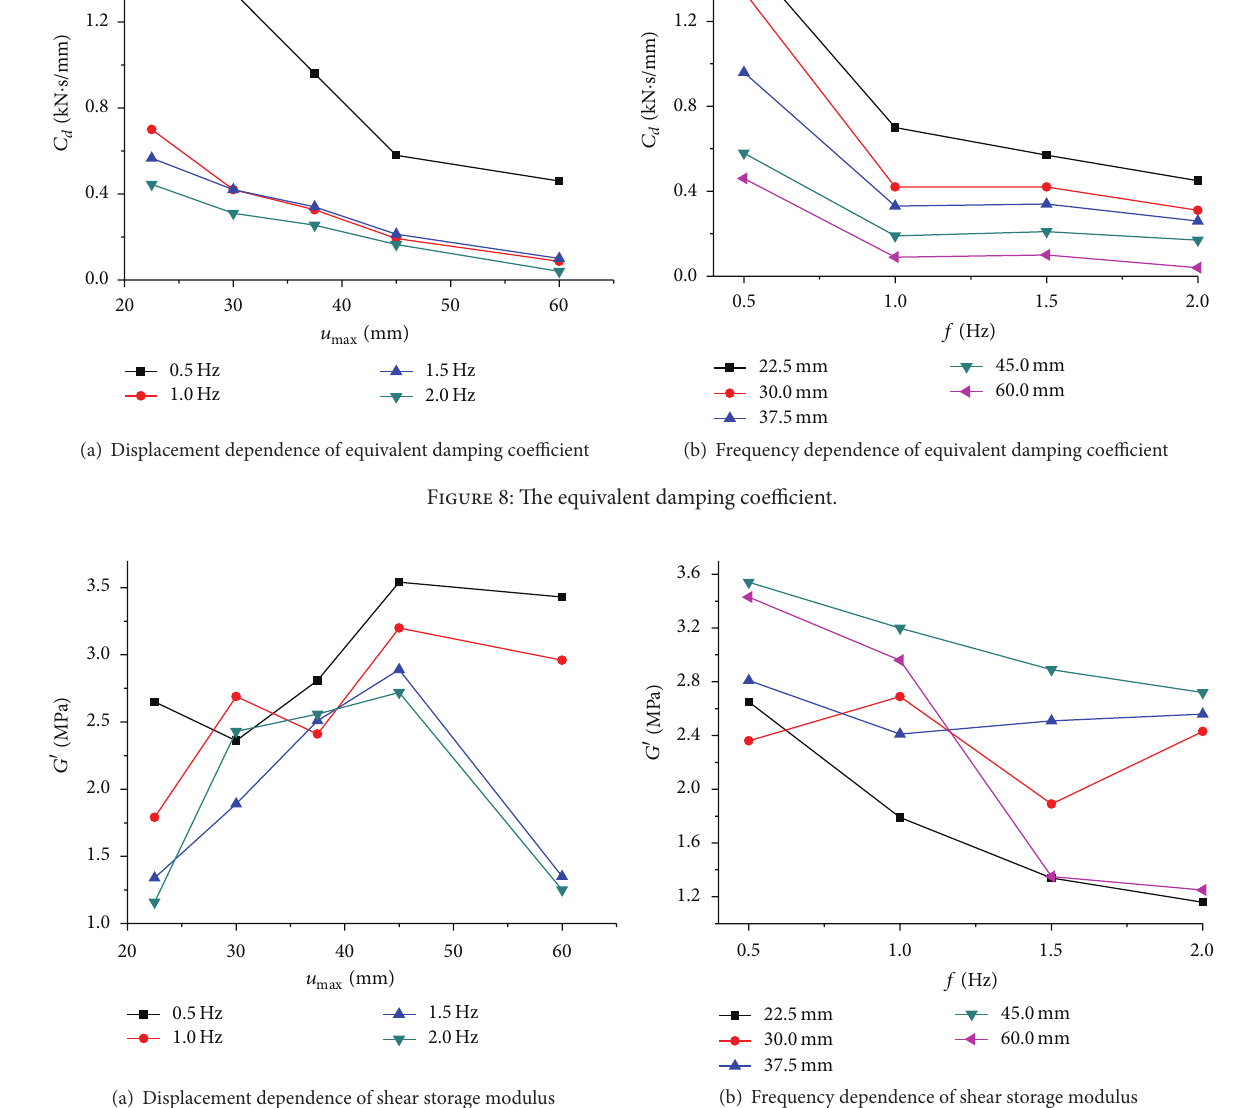
Figure 9: The shear storage